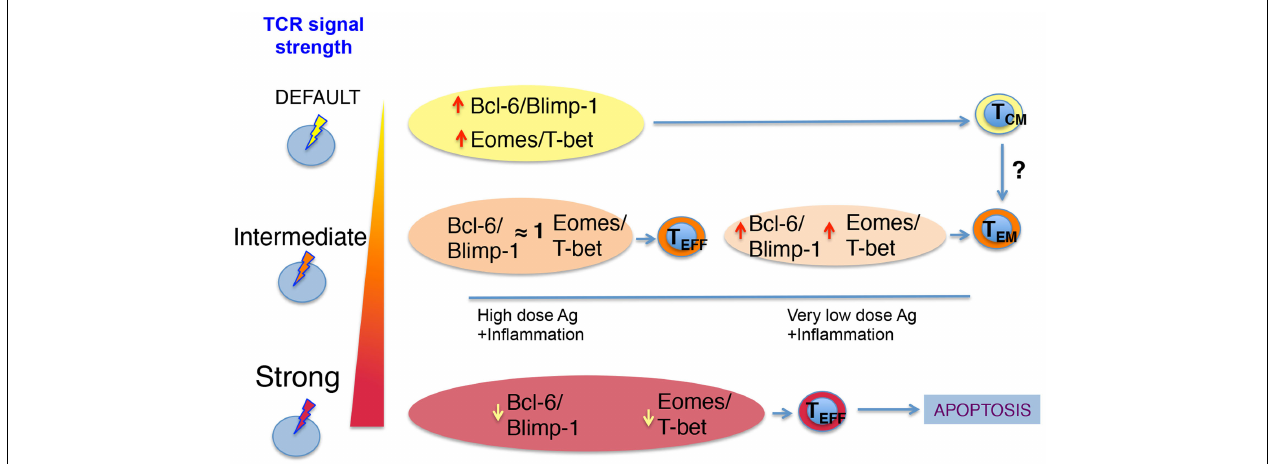
FIGURE 1 | Proposed model of how TCR signal strength regulates CD8 T cell memory differentiation . The interactions of TCR–pMHC on a naïve CD8 T cell triggers TCR signals of varying strength. A default TCR signal leads to low levels of T-bet and Blimp-1 and higher levels of Eomes and Bcl-6 skew the naïve T cell into a central-memory phenotype. This weak TCR signal can be achieved by strong or very weak ligands. If the TCR signal is intermediate, then T cells integrate IL-2 and other pro-inflammatory signals, which allow for similar up-regulation of all transcription factors depicted. This ensures the acquisition of effector function early in the response. Once antigen and inflammation decrease due to clearance of the pathogen, effector T cells decrease their levels of Blimp-1 and T-bet and regain higher ratios of Bcl-6/Blimp-1 and Eomes/T-bet allowing them to become memory T cells. For the cases where the naïve T cell receives very strong TCR signals, the Bcl-6/Blimp-1 and Eomes/T-bet ratios are too low and ultimately lead to